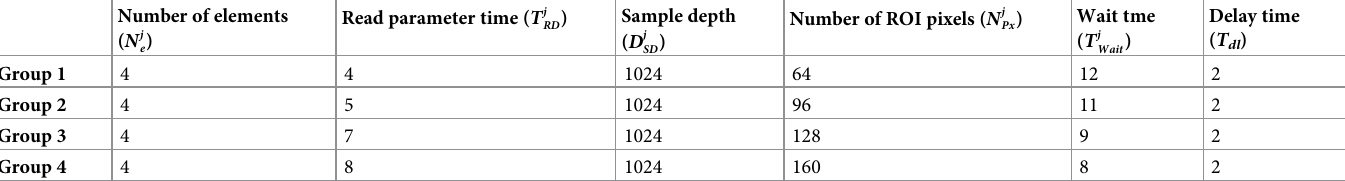
Table 8. Parameters used in FPGA implementation.